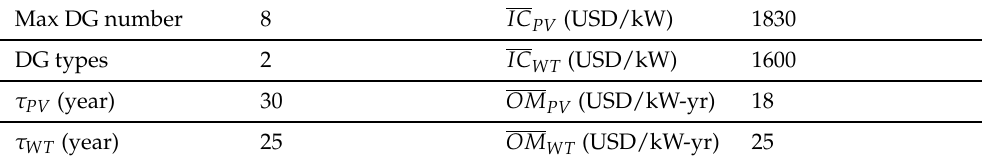
Table 1. DG parameters